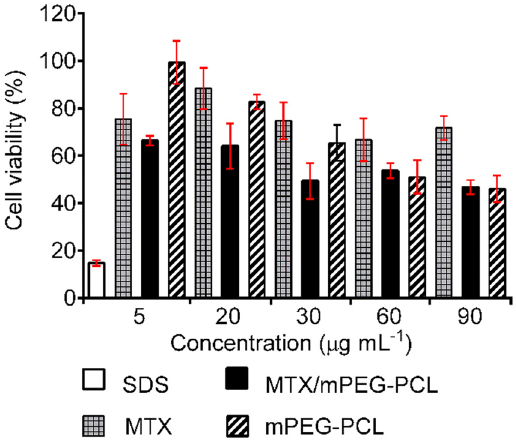
Figure 9: Cytotoxic e ff ect of free MTX, MTX/mPEG - PCL, and mPEG - PCL micelles to MCF - 7 cells, determined by MTT assay at 48 h of incubation. The data are presented as mean ±